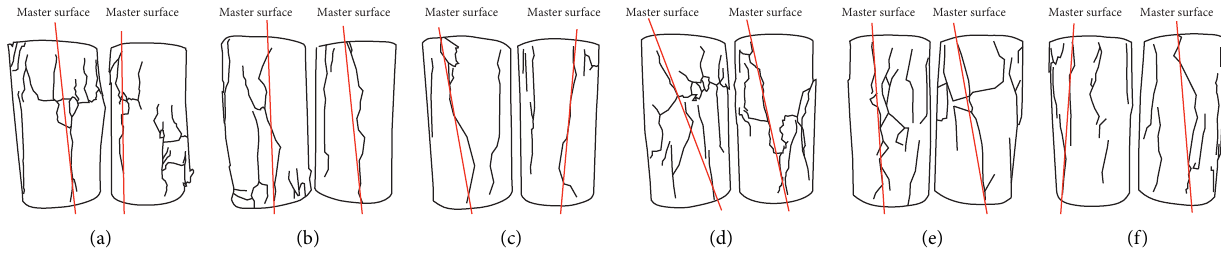
Figure 18: Destruction sketch of cement paste. (a) Group A. (b) Group B. (c) Group C. (d) Group D. (e) Group E. (f) Group F.